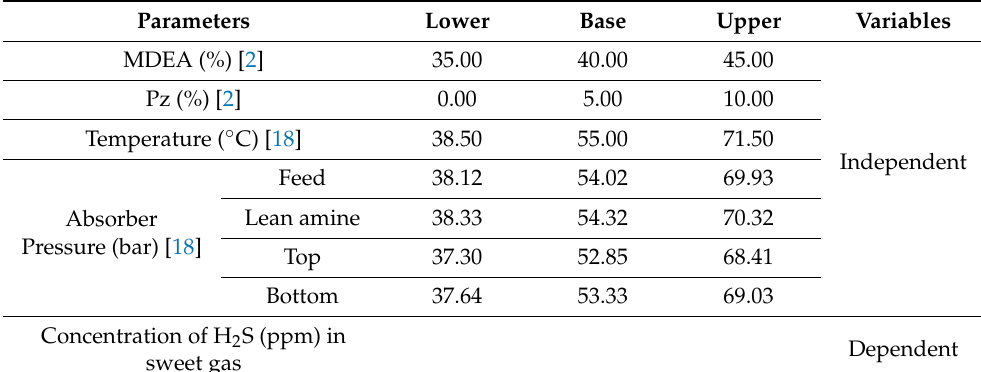
Table 3. List of independent and dependent variables corresponding with their lower and upper limits for data generation.